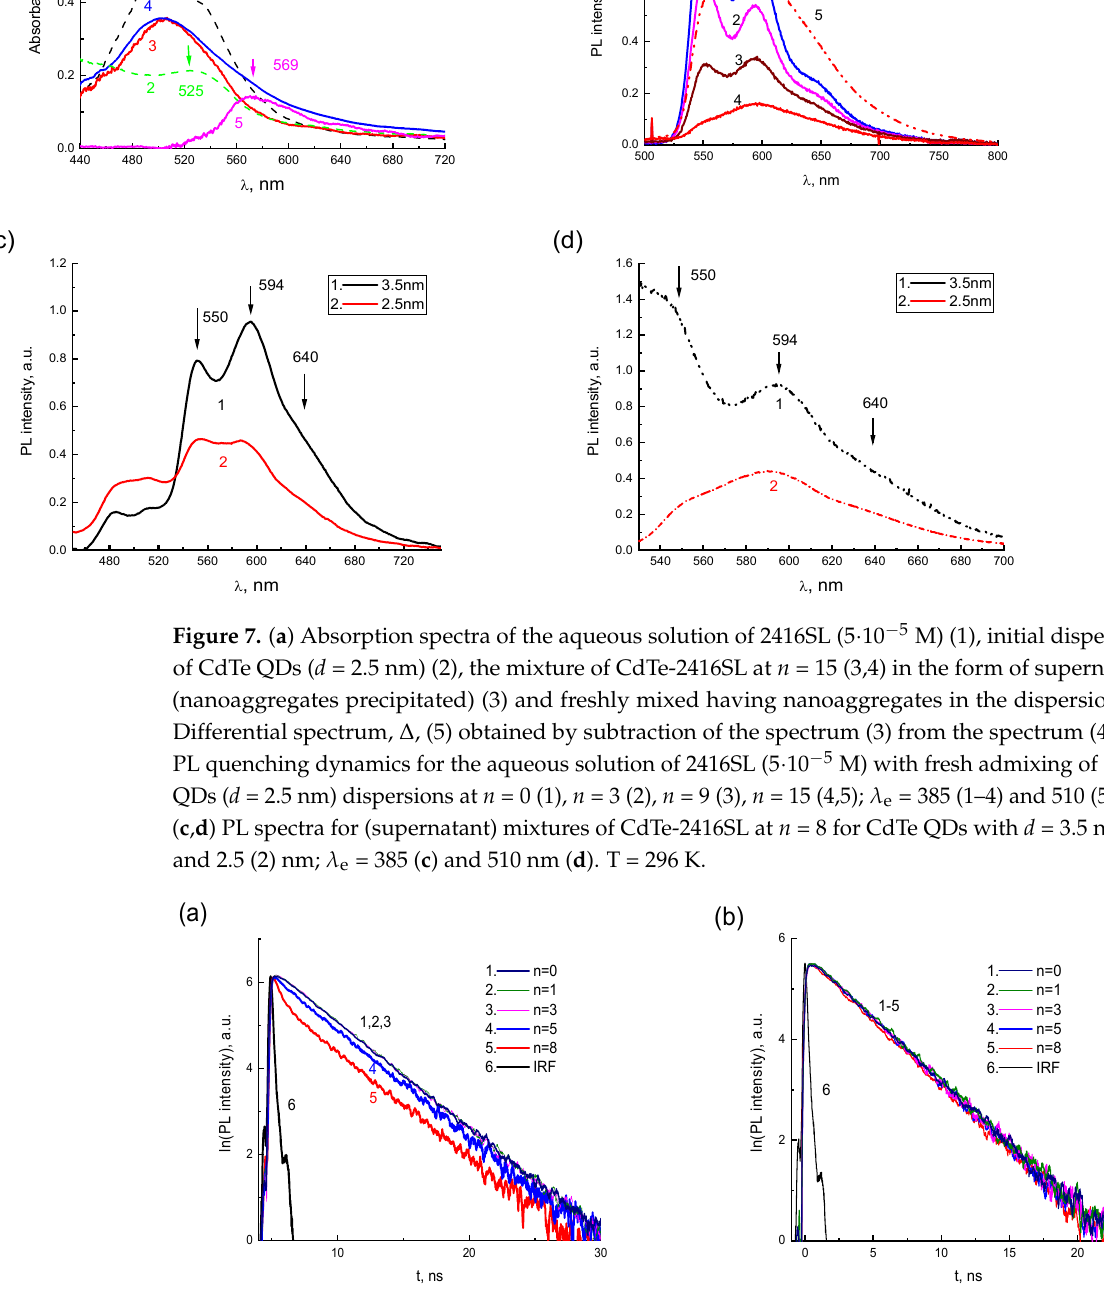
Figure 8. PL kinetics for CdTe-2416SL mixtures at λ EM = 550 nm ( a ) and 620 nm in ( b ) depending on the concentration of CdTe ( d = 3.5 nm) QDs ( V n ): n = 0 (1), n = 1 (2), n = 3 (3), n = 5 (4), n = 8 (5); λ e = 405 nm. T = 296 K. Table 5. PL lifetimes for CdTe ‐ 2416SL mixtures depending on λ EM and the concentration of CdTe ( d